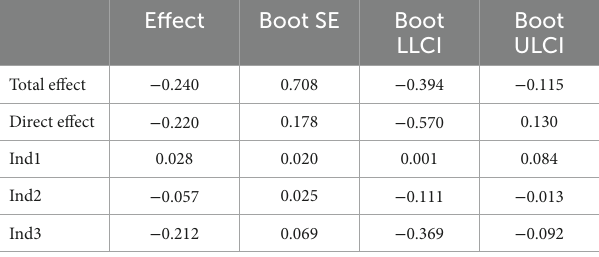
SE, standard error; LLCI, lower limit confidence interval; ULCI, upper limit confidence interval. Ind1: Satisfaction with care quality → Cognitive reappraisal → Anxiety. Ind2: Satisfaction with care quality → Cognitive reappraisal → Perceived stress → Anxiety. Ind3: Satisfaction with care quality → Perceived stress →